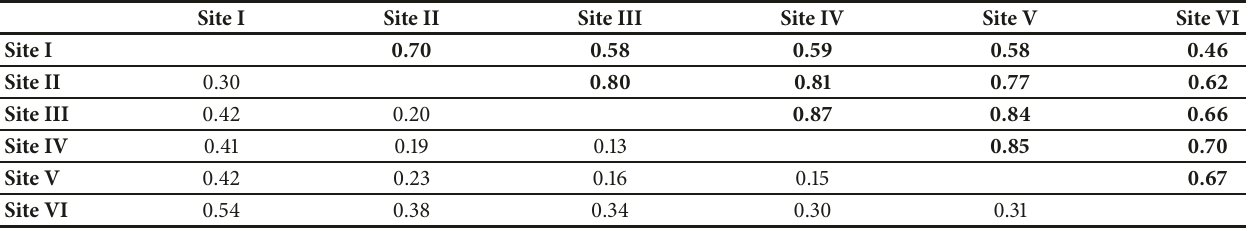
Table 16: Index of similarity and dissimilarity among different sites for Musharni Mai BZCF.